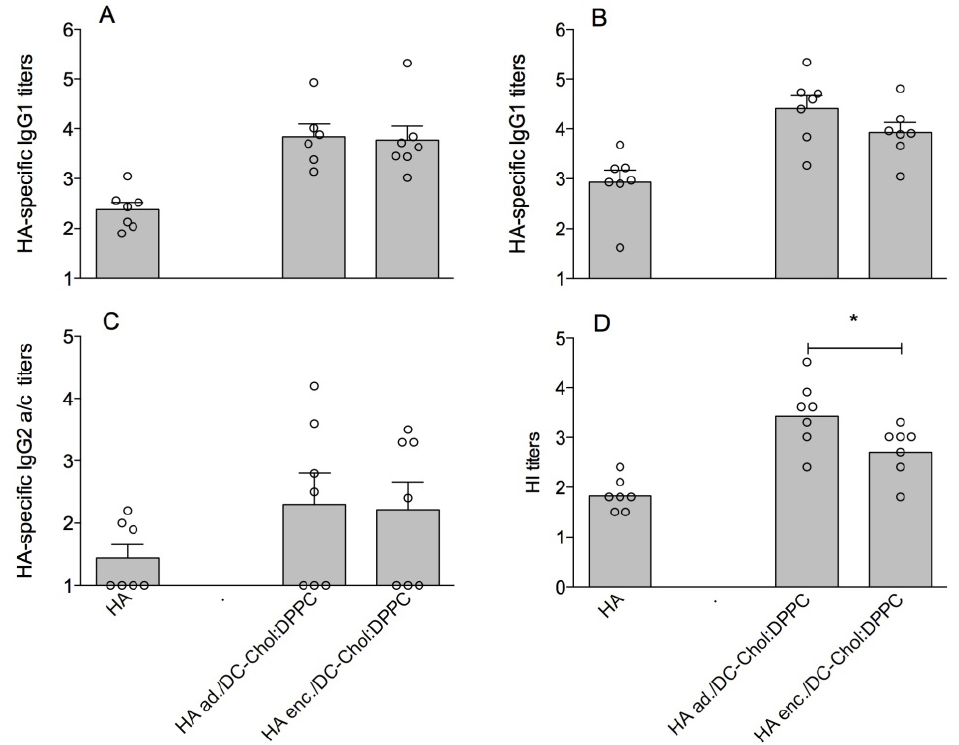
Figure 1. Immune response in mice vaccinated with 2.0 µg of free HA versus HA adsorbed to DC-Chol:DPPC liposomes (HA ad./DC-Chol:DPPC) and HA encapsulated in DC-Chol:DPPC liposomes (HA enc./DC-Chol:DPPC): HA-specific serum IgG1 titer after prime ( A ) and boost ( B ); IgG2a/c titer after boost ( C ); and HI titer after boost ( D ). For panels A–C, each dot represents the log serum titer of an individual mouse (non-responding mice were given an arbitrary titer of 10) and bars represent average log titer + SEM. For panel D, each dot represents the log HI titer in serum of an individual mouse and bars represent the geometric mean. Significant differences between the groups treated with liposomal formulations are indicated with * ( p <